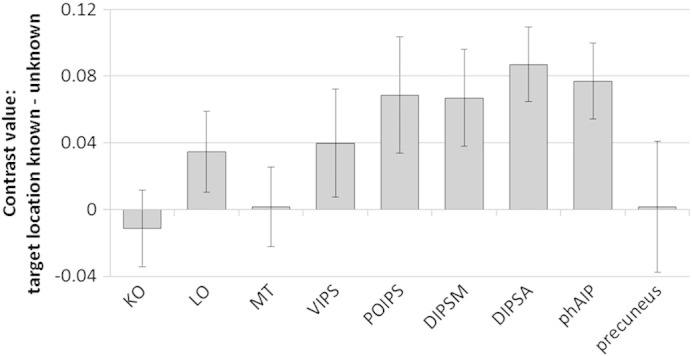
Change in activation in specific regions of interest when the location of the target was known versus unknown. Error bars show standard errors. KO, kinetic occipital; LO, lateral occipital; MT, MT/MT +; VIPS, ventral intraparietal sulcus; POIPS, parieto-occipital intraparietal sulcus; DIPSM, medial dorsal intraparietal sulcus; DIPSA, anterior dorsal intraparietal sulcus; phAIP, putative human anterior intraparietal area.